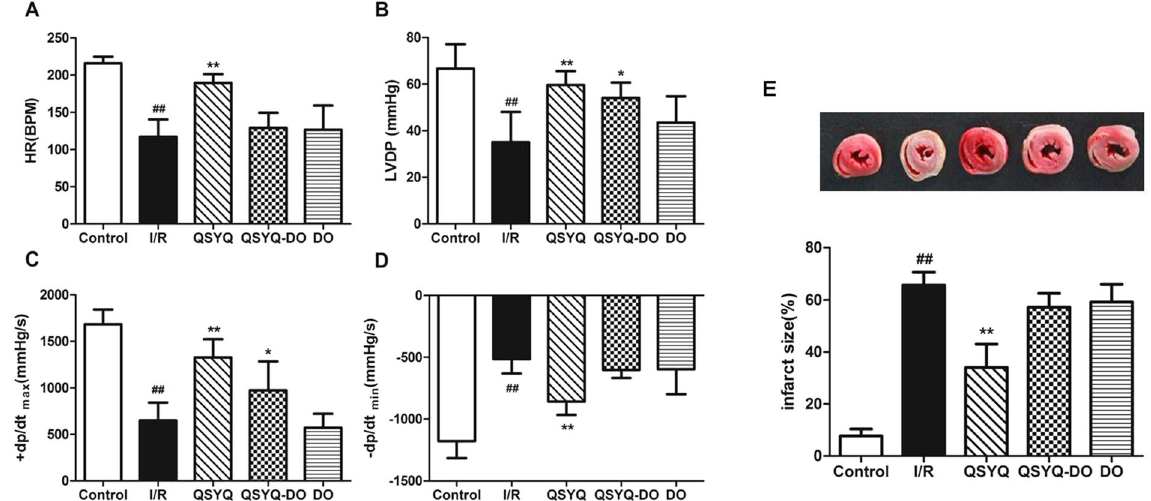
Figure 3. Effects of QSYQ and QYSQ-DO on cardiac function and myocardial infarction size in isolated rat hearts. The hearts underwent 20 min of stabilization, 30 min of ischemia, and 60 min of reperfusion. Drugs were administered before ischemia for 10 min. Cardiac functions were determined by Powerlab data acquisition system. Infarct size was evaluated by TTC staining. ( A ) Heart rate (HR). ( B ) Left ventricular developed pressure (LVDP). ( C and D ) Maximal and minimum rate of pressure development ( ± dp/dt max), respectively. (E) Infarct size (%). All parameters were measured at the end of the reperfusion period. Data are expressed as mean ± SD, n = 4. ## p < 0.01 vs . Control group. * p < 0.05, ** p < 0.01 vs . I/R